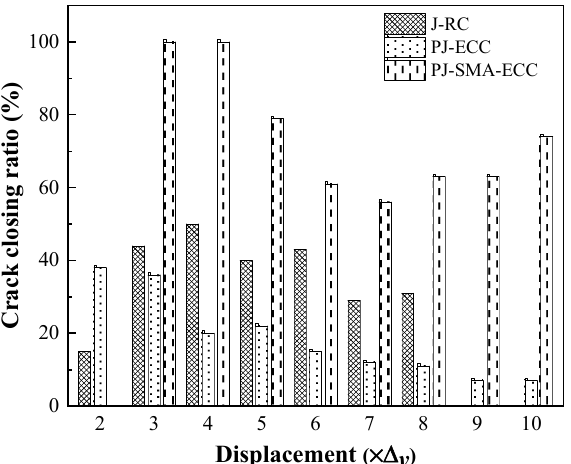
Figure 16. The crack closing ratio in the joint zone.